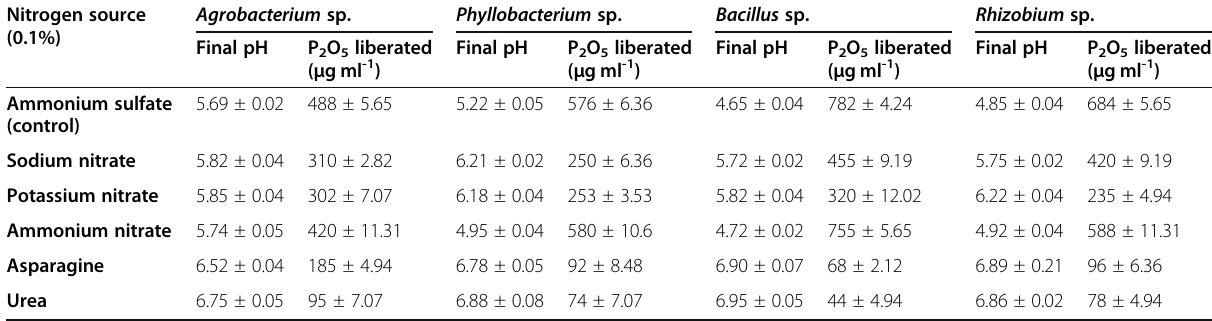
Table 4 Effect of different nitrogen sources on the tricalcium phosphate solubilization by the tested rhizobacterial strains Nitrogen source